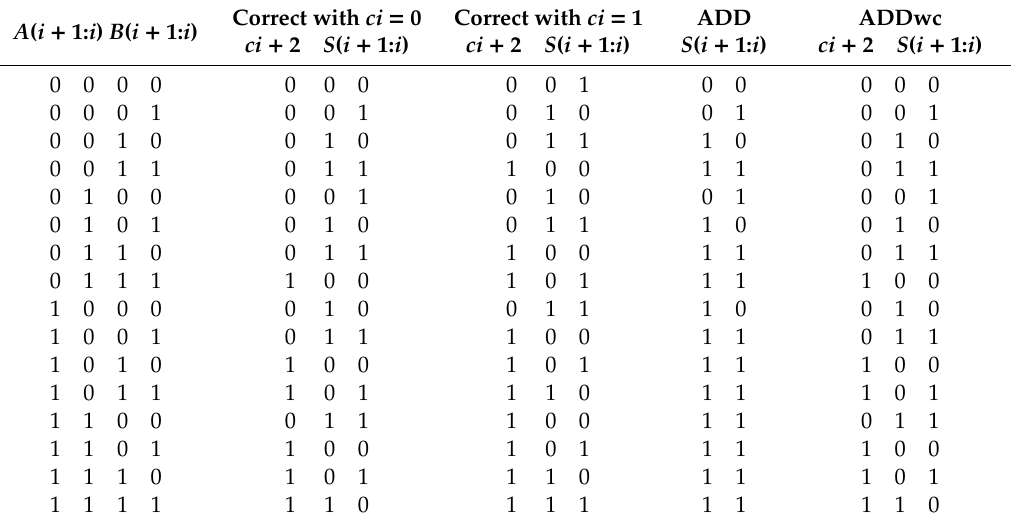
Table 1. The basic logic of the proposed approximation